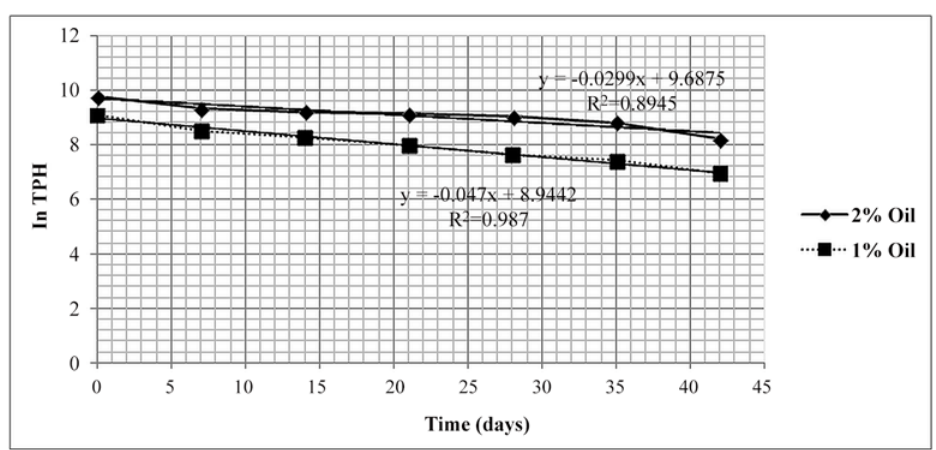
Fig 5. First order graph showing in TPH as crude oil waste against time for the remediation